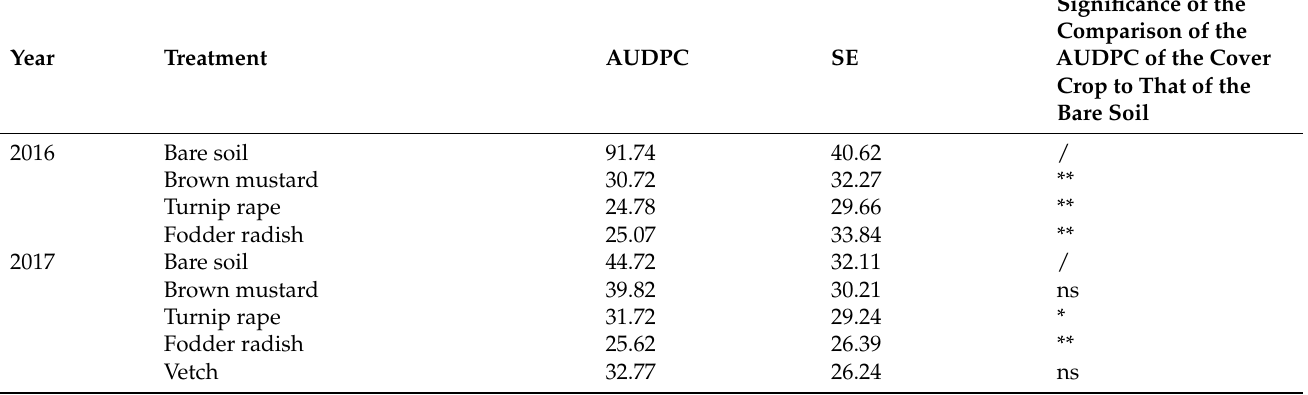
Table A3. Area under disease progression curve (AUDPC) of sunflower verticillium wilt severity, calculated from the appearance of symptoms up to 80–85 days after sowing, after bare soil, cover crops in sole crop and in a mixture of two or three species in 2016, 2017, 2019 and 2020. SE represents the standard error. Abbreviations ns, *, **, indicate non-significant, or significant differences at p < 0.05, 0.01, respectively between the bare soil and the cover